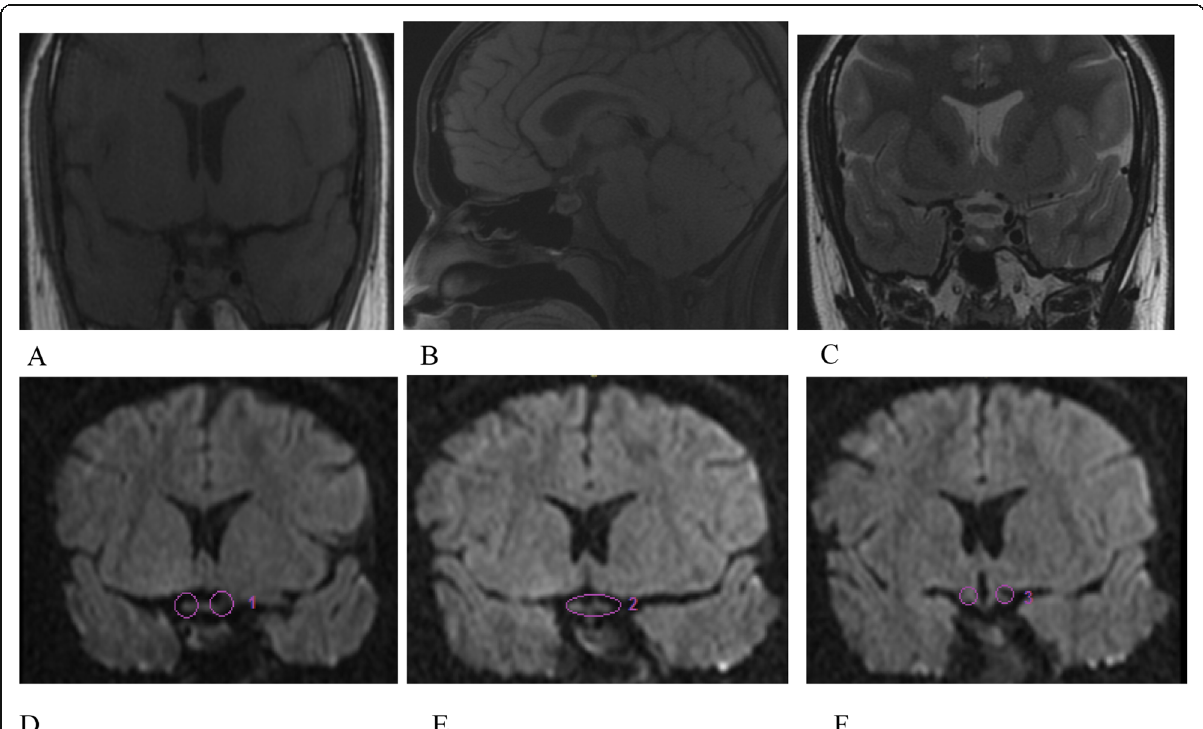
Fig. 3 A case of 29-year-old female patient presented with headache and amenorrhea. MRI of the sella coronal T1 ( a ) and sagittal T1 ( b ), coronal T2 ( c ), and DTI of the optic pathway were done and ROI delineation on DTI maps. Color ROI are drawn on d anterior optic tracts, e the optic chiasm, and f the posterior optic tracts showing non-enhancing focal lesion in the right side of the pituitary gland measuring 9 × 6 mm in diameter and DTI examination shows the following: FA =0.272, 0, 202, 0.204; ADC = 1.95, 1.97, 1.9 μ m 2 /ms; AD = 2.2, 2.3, 2.2 μ m 2 /ms; and RD = 1.1, 0.9, 1.1 μ m 2 /ms of the anterior optic tracts, the optic chiasm, and the posterior optic tracts